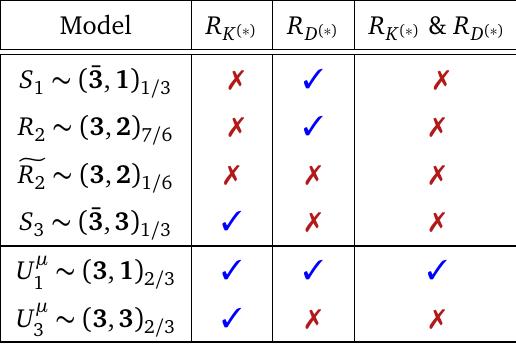
(first column), K ( ∗ ) and R (third column) without introducing K ( ∗ ) D ( ∗ )